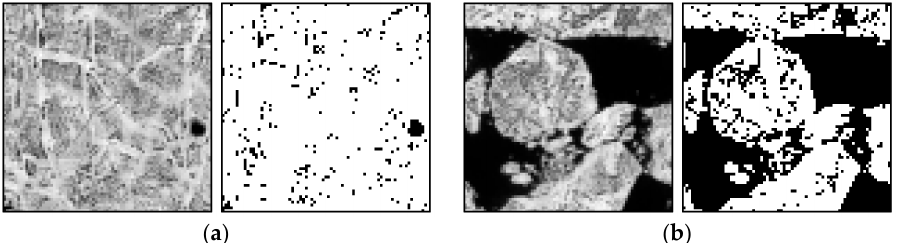
Figure 12. The sea ice coverage and entropy of the matched block (75 × 75 pixels equivalent to 1125 × 1125 m) from the same image pair of Figure 11, resampled to the spatial resolution of 15 m: ( a ) 14 bit grey scale image block and binarized sea ice image block showing the maximum sea ice coverage parameter (93.938) and minimum entropy (0.330) of the prior image; and ( b ) 14 bit grey scale image block and binarized sea ice image block showing the minimum sea ice coverage parameter around 50% (51.236) and maximum entropy (1.000) of the prior image. The image blocks were chosen from the blocks designated as the cross-correlation coefficients higher than 0.6.